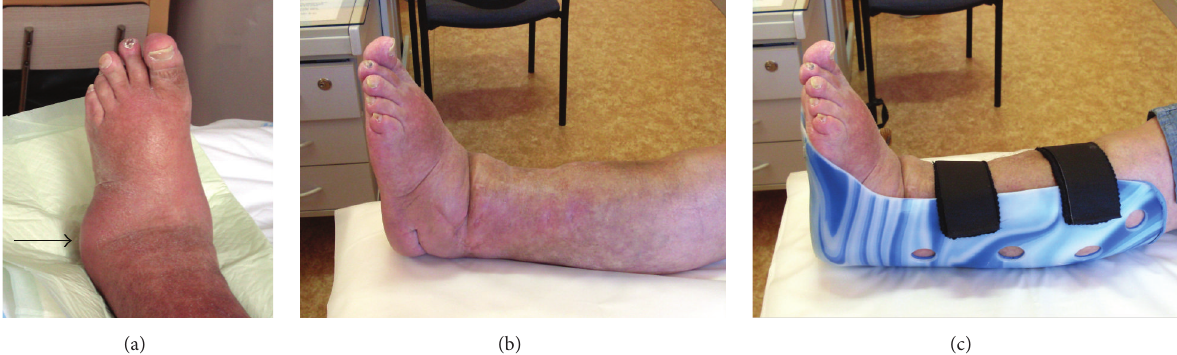
Figure 7: (a) A clinical image of a left foot deformity with complete dislocation of talus plantolaterally (arrow). (b) A clinical image after astragalectomy and completed healing of tibiocalcaneal fusion. (c) Individual plastic orthosis into shoes.